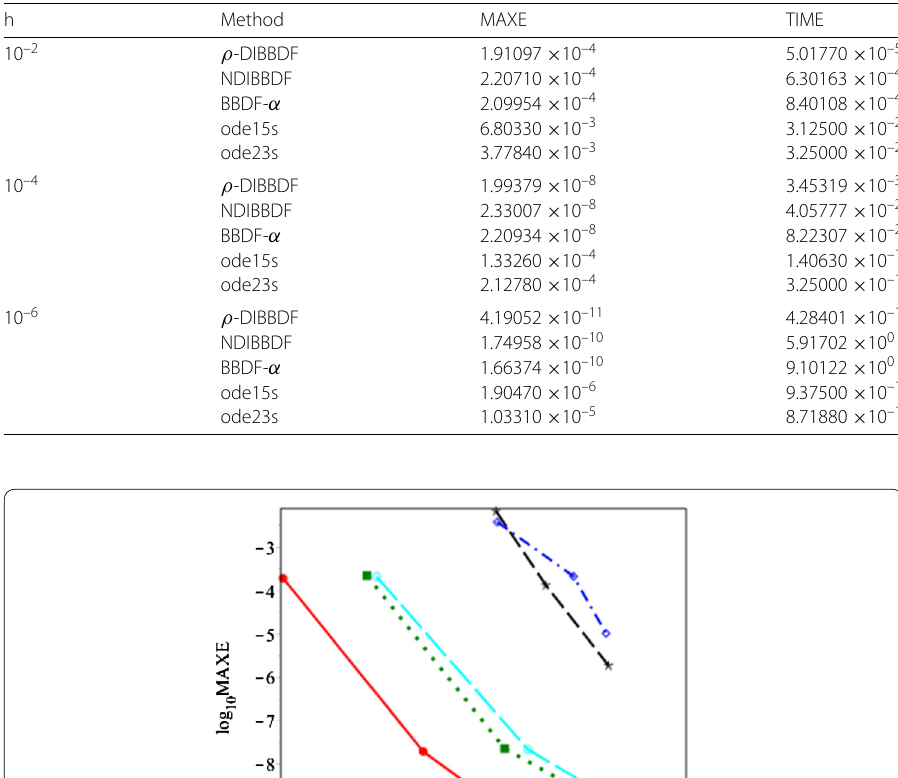
Table 7 Numerical results for concentration of drug in Model B—Compound (iii) h